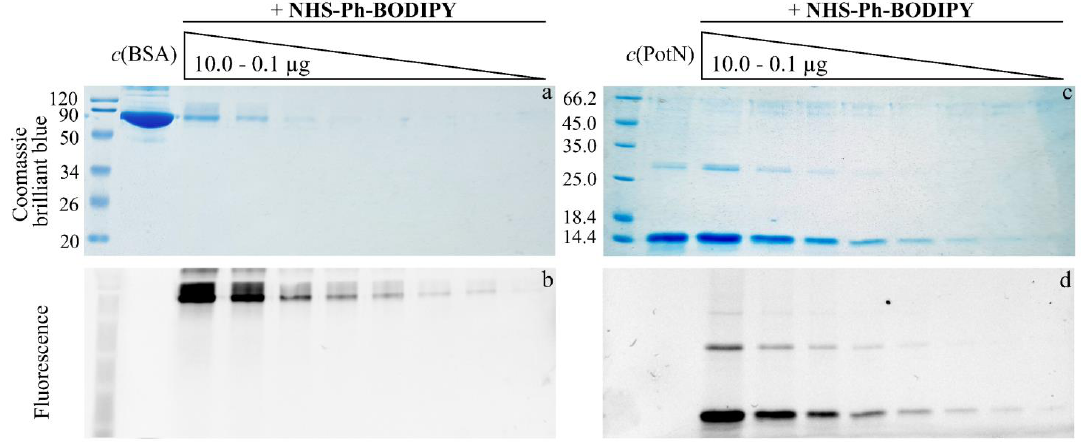
Figure 7. SDS-PAGE of double dilutions of BSA (MW = 66.2 kDa) (left) and PotN (MW = 13.7 kDa) (right) stained with Coomassie brilliant blue ( a , c ) and labeled with NHS-Ph-BODIPY ( b , d ) (each gel contains protein weight marker and unlabeled protein).